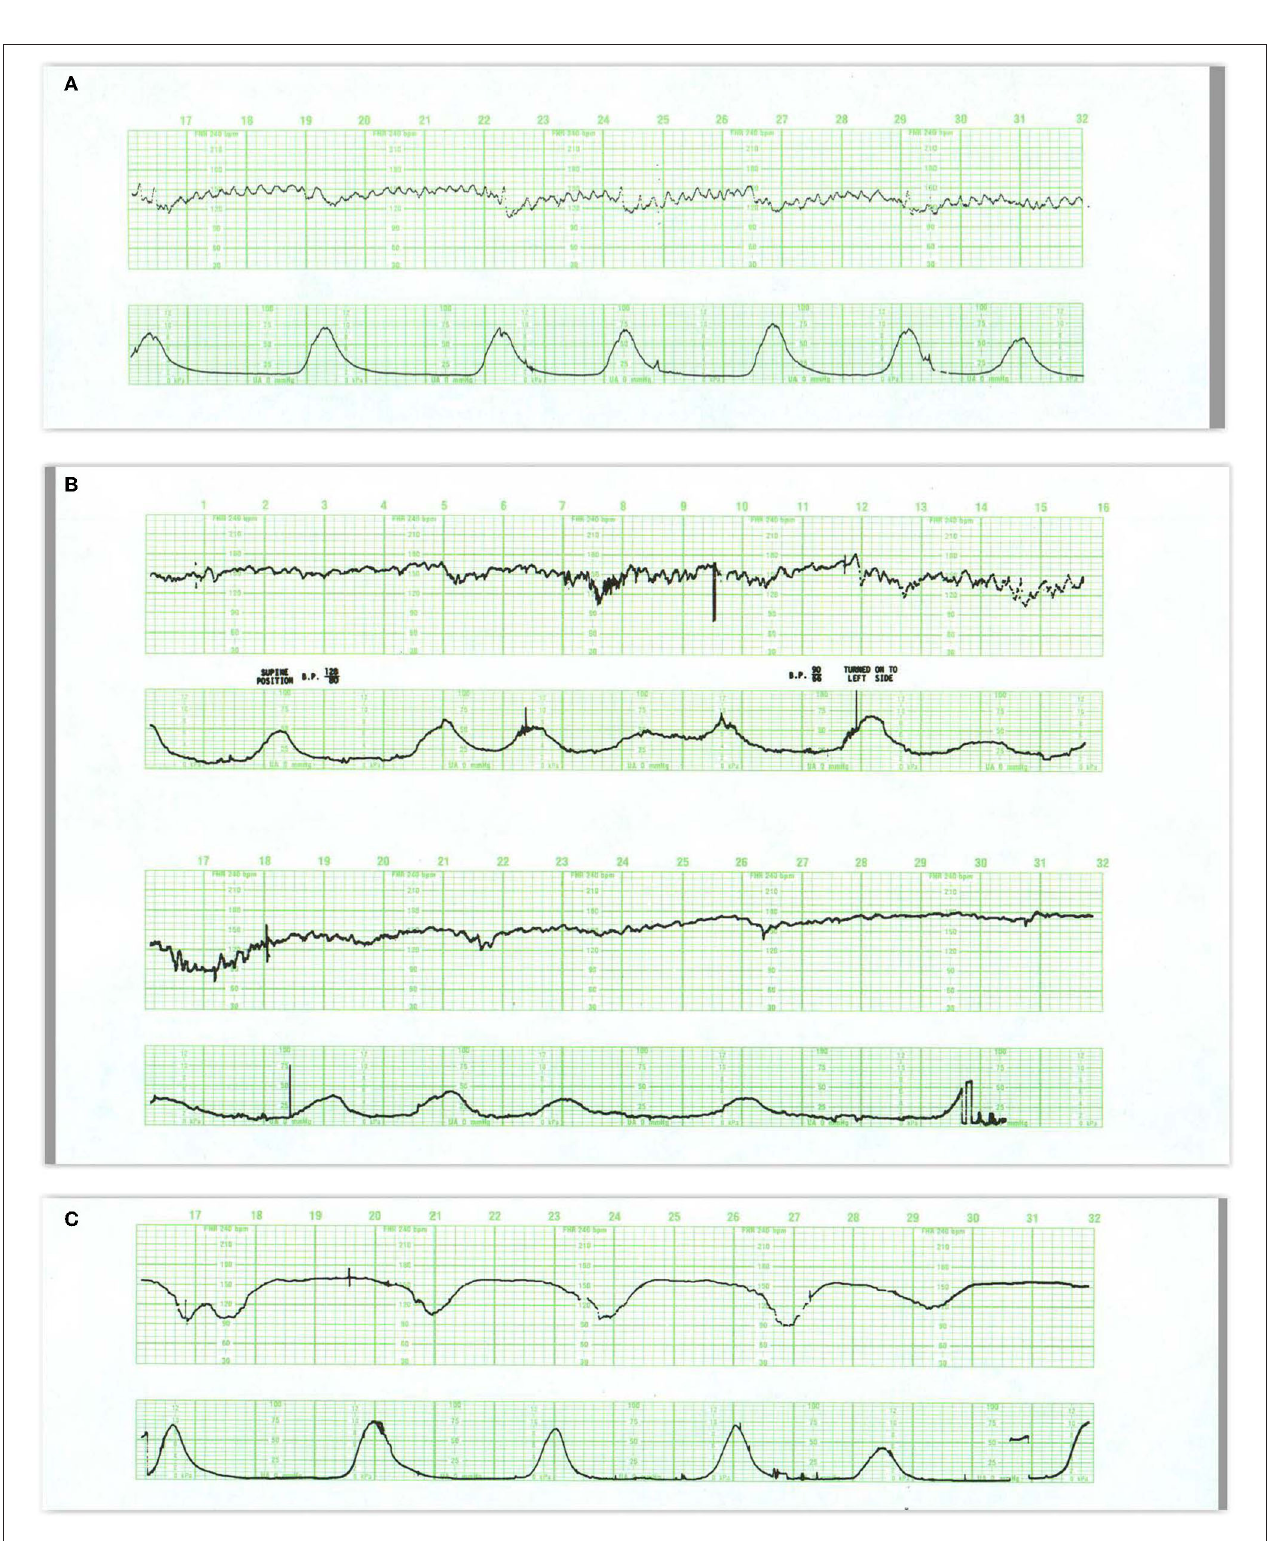
FIGURE 7 | (A) This tracing reveals regular, predictable oscillations interrupted by mild (early) decelerations. These patterns are quite benign and require no intervention. They do represent fetal head compression with variable decelerations when pushing starts in the second stage. (B) Illustrates the development of late decelerations following epidural anesthesia and maternal hypotension. Notice the increased frequency of contractions immediately after the epidural. During recovery,